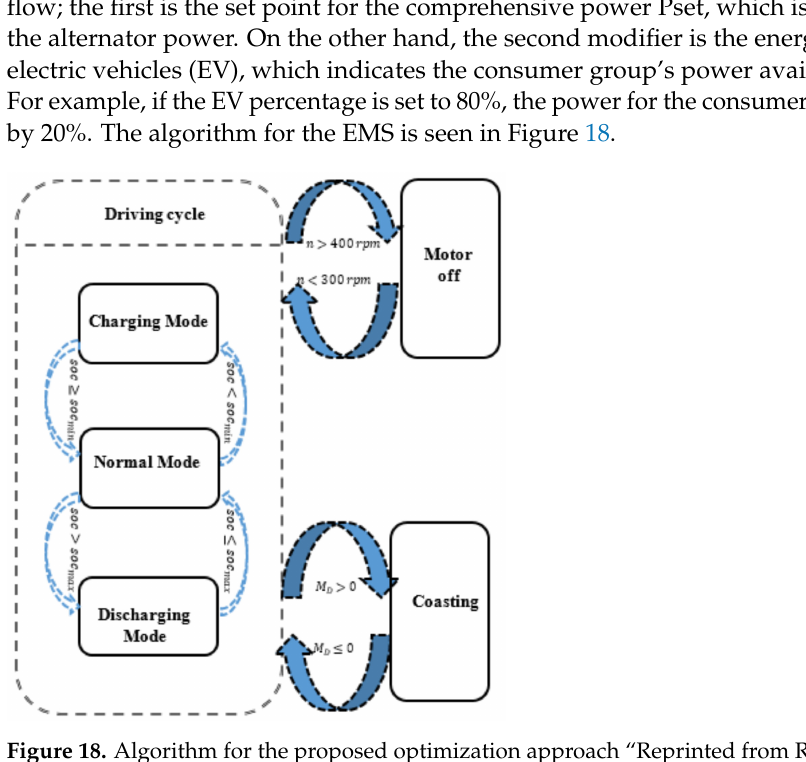
Figure 18. Algorithm for the proposed optimization approach “Reprinted from Ref.